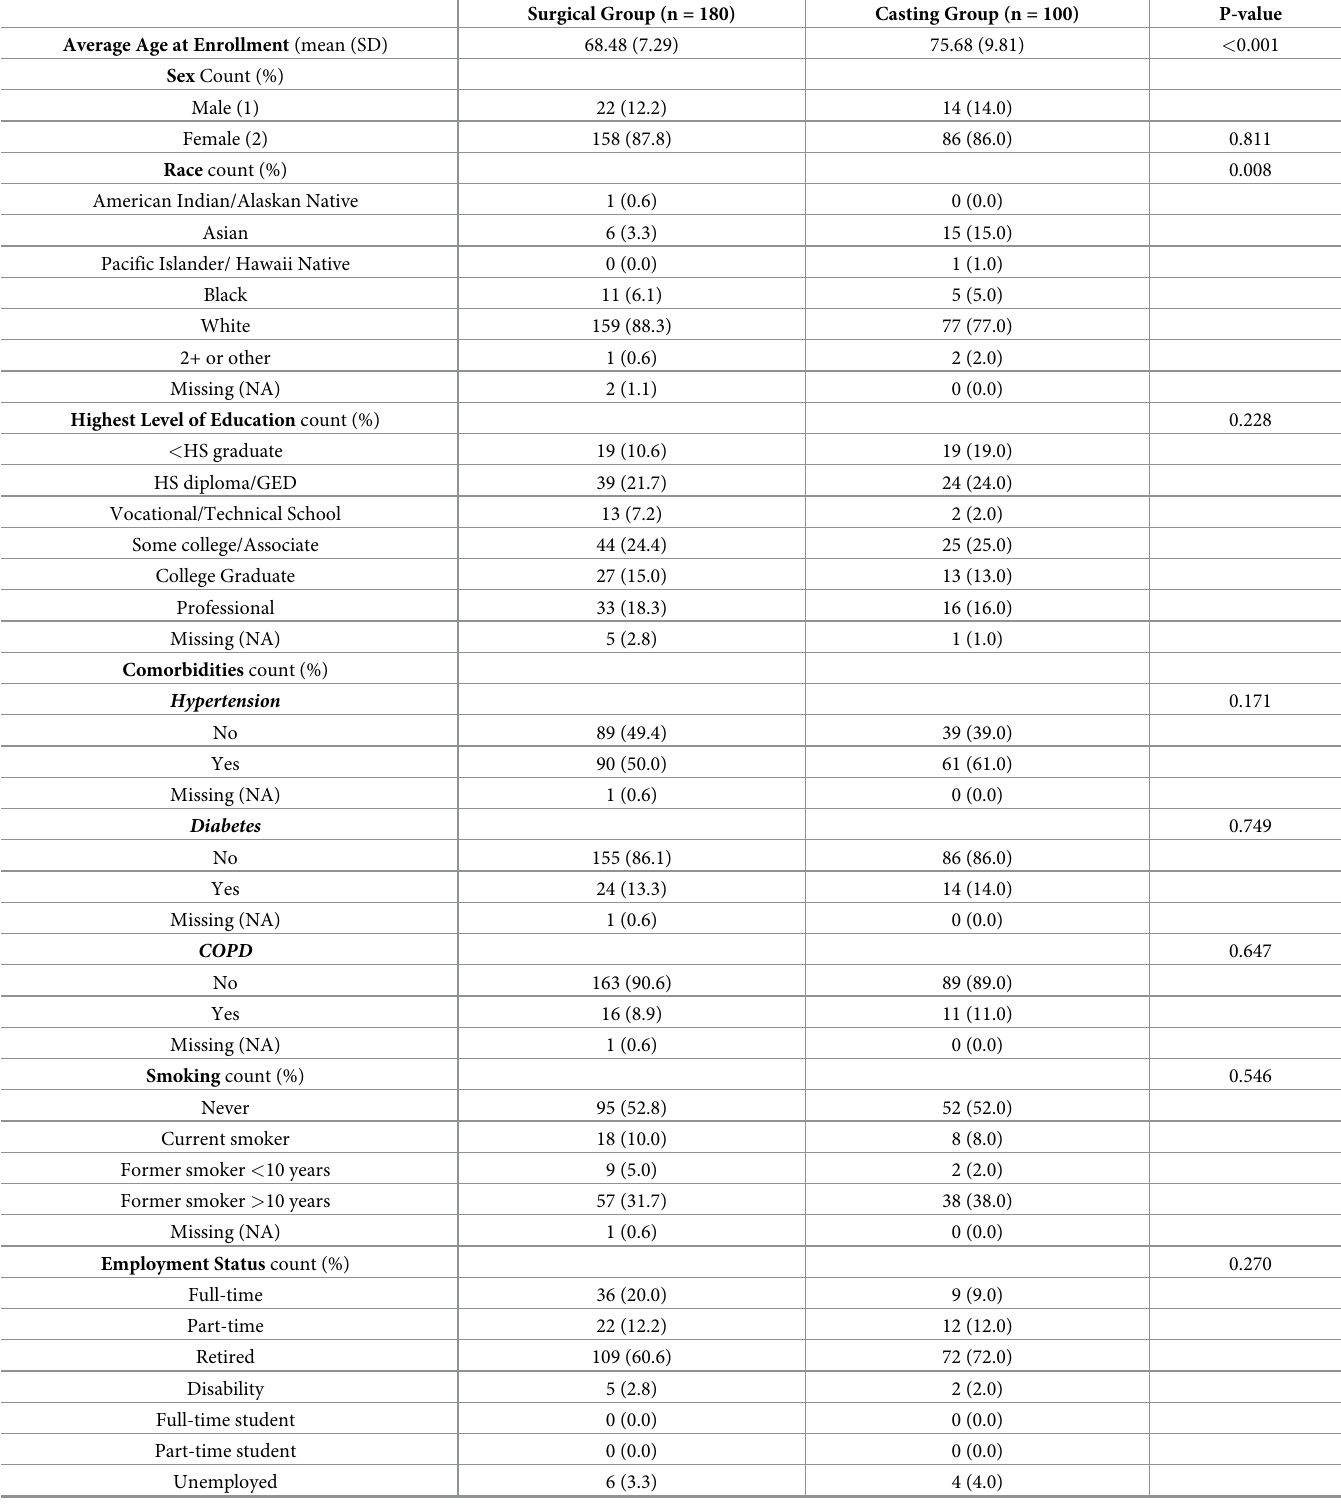
Table 1. Comparison of demographic characteristics among the surgical group (VLPS, ExFix, Pinning) and the casting